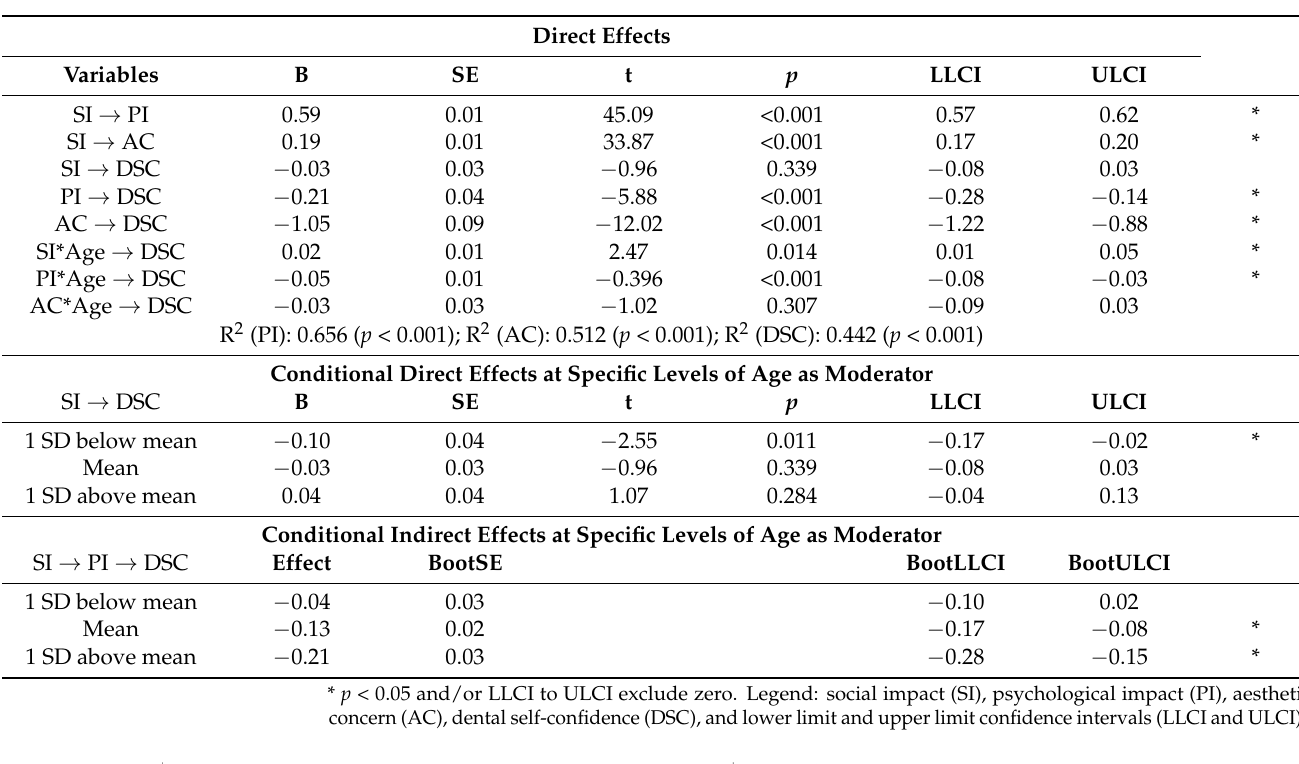
Table 4. Moderated mediation analysis when treating age as a mediator.